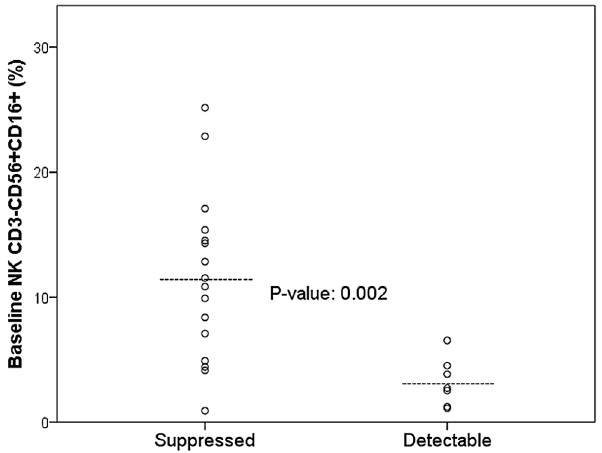
Figure 1. Baseline NK Cell percentages by HIV-1 RNA Outcome following Regimen Simplification. Figure 1 compares the baseline NK cell levels, defined by CD3-CD56 + CD16 + cells, and virologic outcome (HIV-1 RNA below or above 50 copies/mL, throughout the study). The circles represent each study participant with either sustained HIV-1 RNA suppression during the trial and those participants who developed detectable viremia following treatment simplification. The difference in the median NK cell levels between the groups with detectable and suppressed viremia was statistically significant with a p- value of 0.002. The median level is noted by the line in the scatterplot for each group.